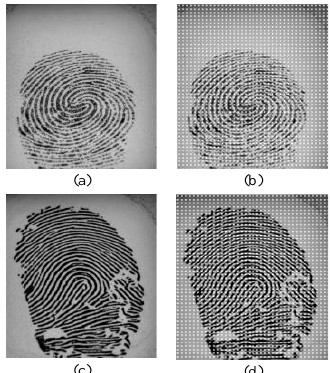
Figure 2. True and fake fingerprints and their visualizations using histograms of oriented gradients (HOG): ( a ) true fingerprint; ( b ) true fingerprint visualization; ( c ) fake fingerprint; ( d ) fake fingerprint visualization.